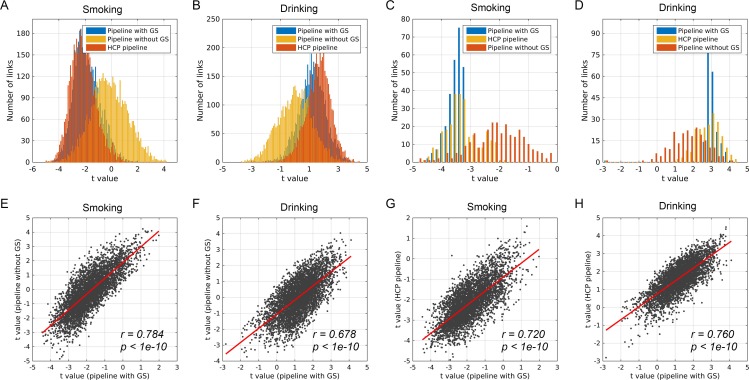
A comparison of the whole brain functional connectivity difference patterns between different pipelines of data preprocessing.The upper figures show the distribution of t values of the whole brain links for three different pipelines of data preprocessing. (A) For smoking and (B) for drinking. (C, D) showed the distribution of t values of significantly different links for three different pipelines of data preprocessing. (E, F) show the correlation between the t value corresponding to the pipeline with GS (global signal) and the t value corresponding to the pipeline without the GS, that is with the global signal regressed out. (G, H) show the correlation between the t value corresponding to the pipeline with GS and the t value corresponding to the HCP pipeline.